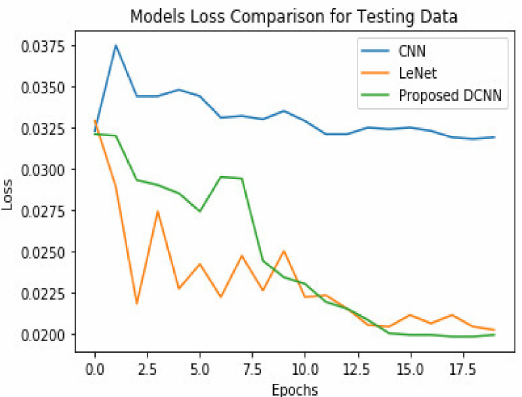
Figure 14. Loss Comparison of CNN, LeNet, and the Proposed DCNN on the Pashto Digits Dataset.